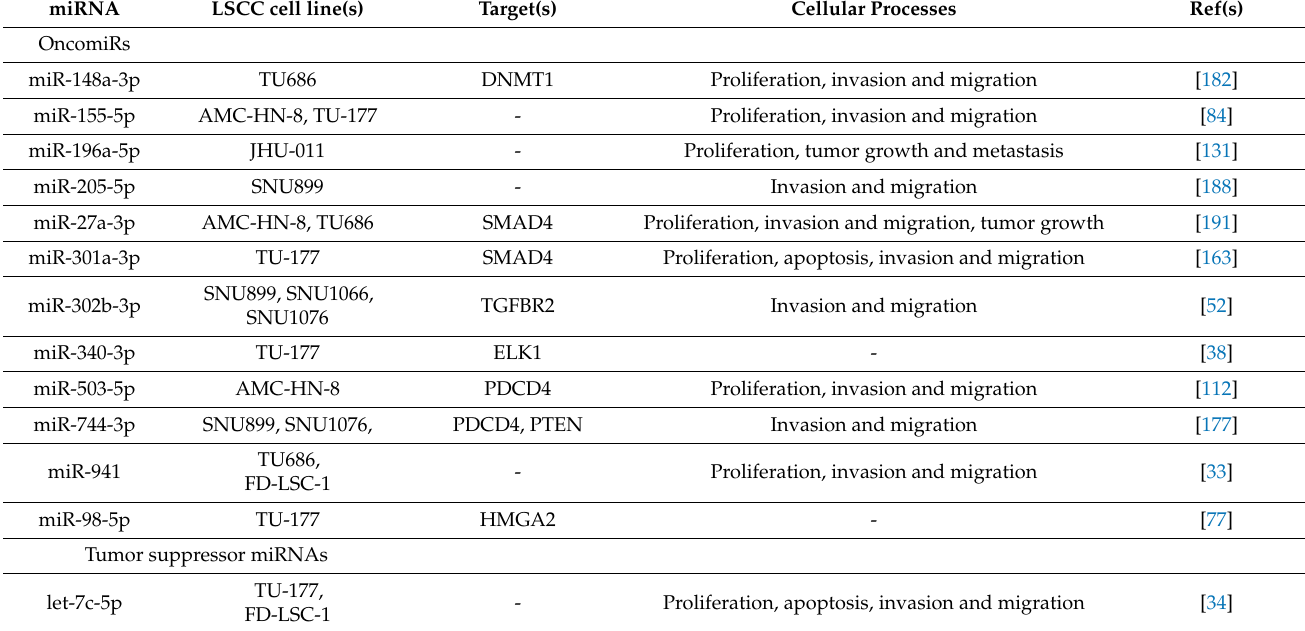
Table 7. miRNA’s functional role in LSCC cell line